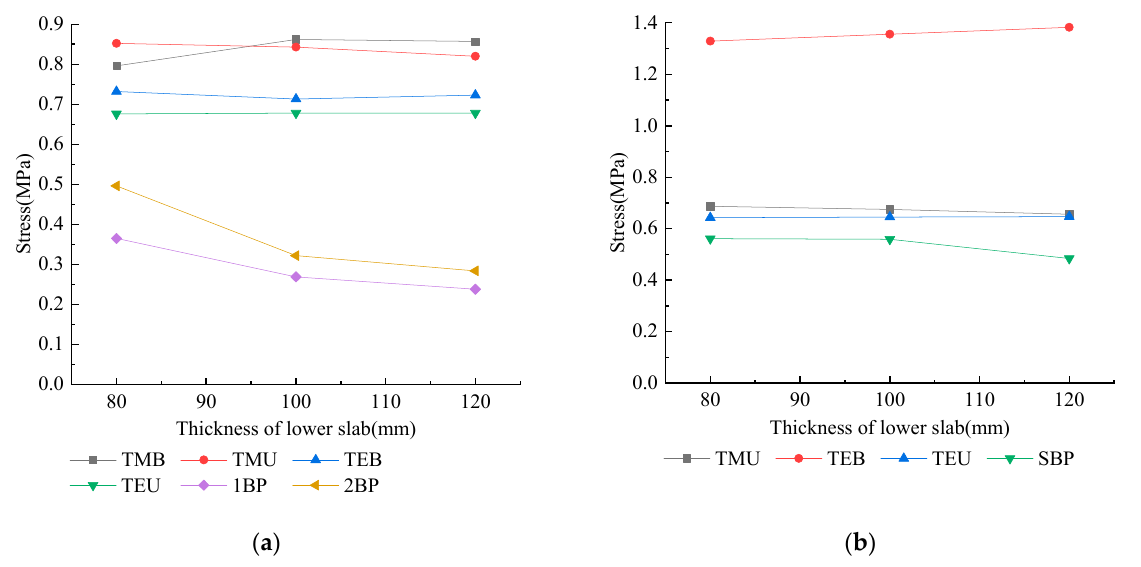
Figure 15. The stress change trend of the rail seats and the cast-in-place concrete under different lower slab thickness conditions during the running period. ( a ) Rail seats and ( b ) cast-in-place concrete.